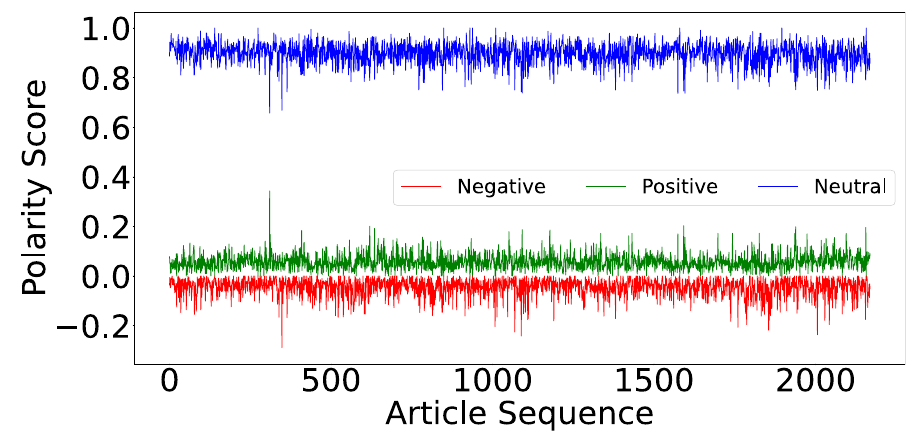
Fig 4. Illustrating the variation in sentiment scores for articles. The positive, negative, and neutral sentiments for each article reveals the ratio of polarities within an article.